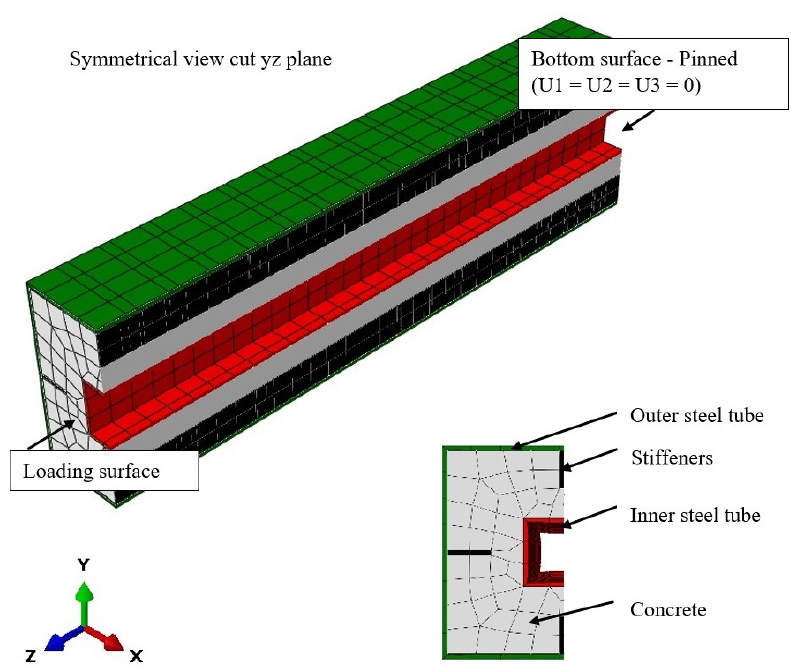
Figure 12. Boundary conditions and element mesh